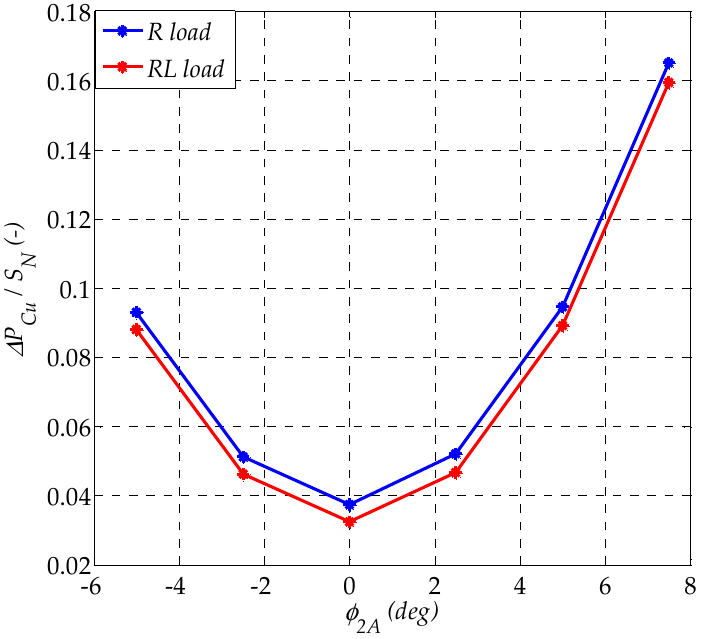
Figure 12. Load losses of the transformer with phase control as a function of the angular value of this phase, at U 2A = 1.037·U 2Nphase .